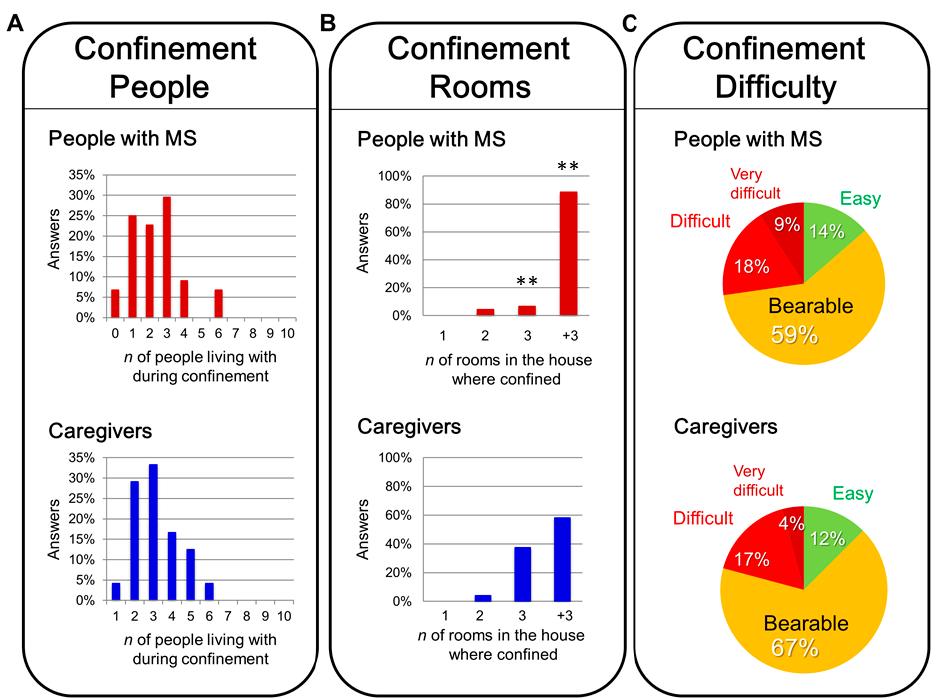
Figure 1. Confinement–people, rooms, and difficulty. Sample distribution of the people with MS and caregivers answering to the number of people living with them during the confinement ( A ), the number of rooms of the house where they were confined ( B ), and the level of difficulty they had handling the period of confinement ( C ). Statistics: Fisher’s test, ** p < 0.01 People with MS vs. caregivers.